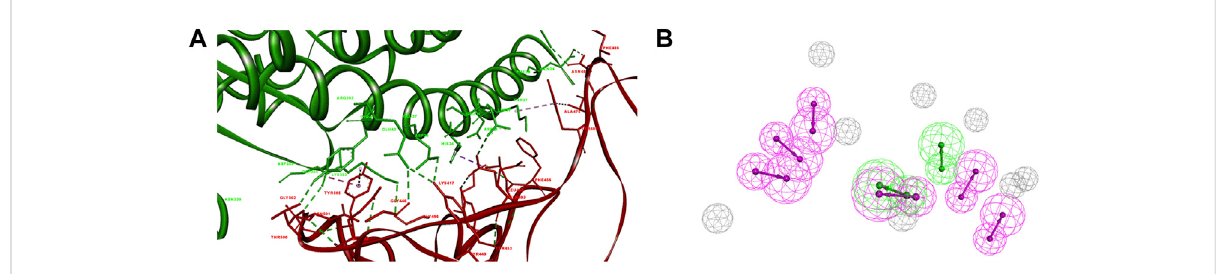
FIGURE 1 Pharmacophore of SARS-CoV-2-RBD-hACE2 interface. (A) The interaction of S-RBD with hACE2. The secondary structural elements were depicted as ribbons (coils, α -helices; arrows, β -sheets). The contacting residues are shown as sticks at the S-RBD-hACE2 interface. The S-RBD and hACE2 were colored in red and green, respectively. The electrostatic interaction was shown as dashed lines with π - π , π -alkyl, and hydrogen bonds colored purple, pink, and green, respectively. (B) The pharmacophore features of S-RBD-hACE2 interface. The colored spheres identify the position and the type of binding features (hydrogen bond donor, magenta; hydrogen bond acceptor,